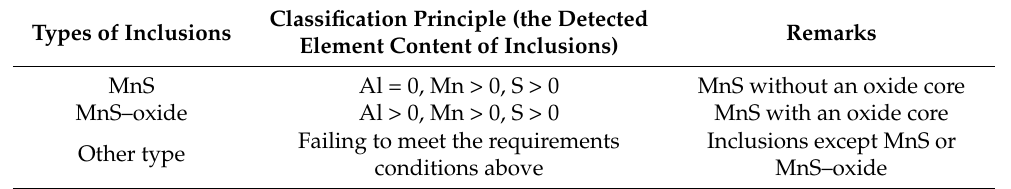
Table 3. Classification principle of inclusions.